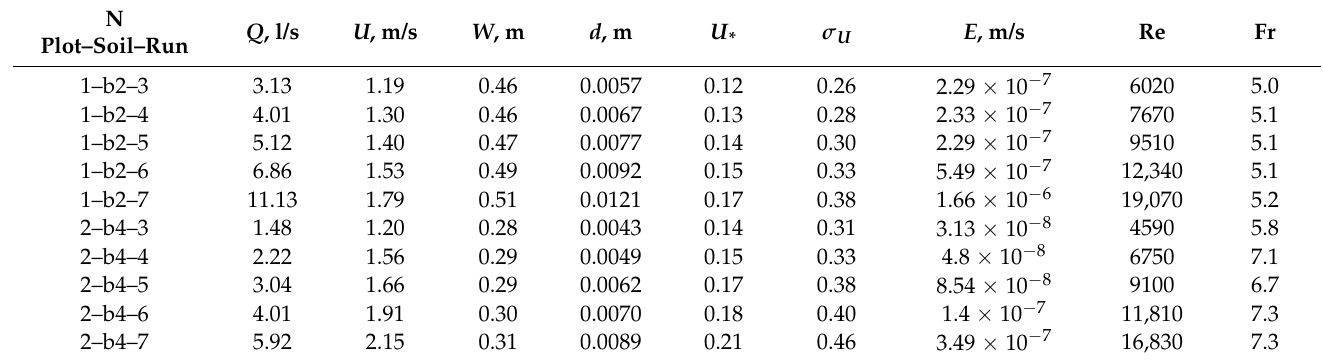
(cid:16) (cid:17) 0.1 + 0.42 S d and varied in the S a 16 ρ s ∼ = 2.1 U ∗